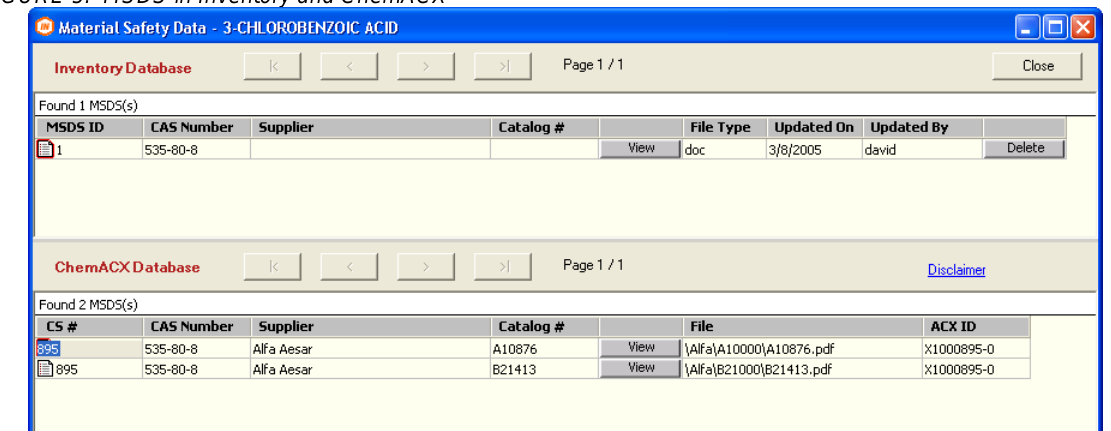
FIGURE 5: MSDS in Inventory and